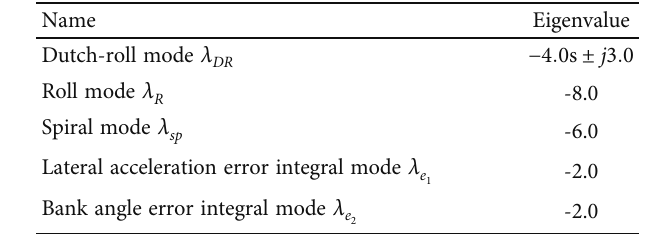
Table 5: Eigenvalues and eigenvectors for the open-loop lateral- directional dynamics.